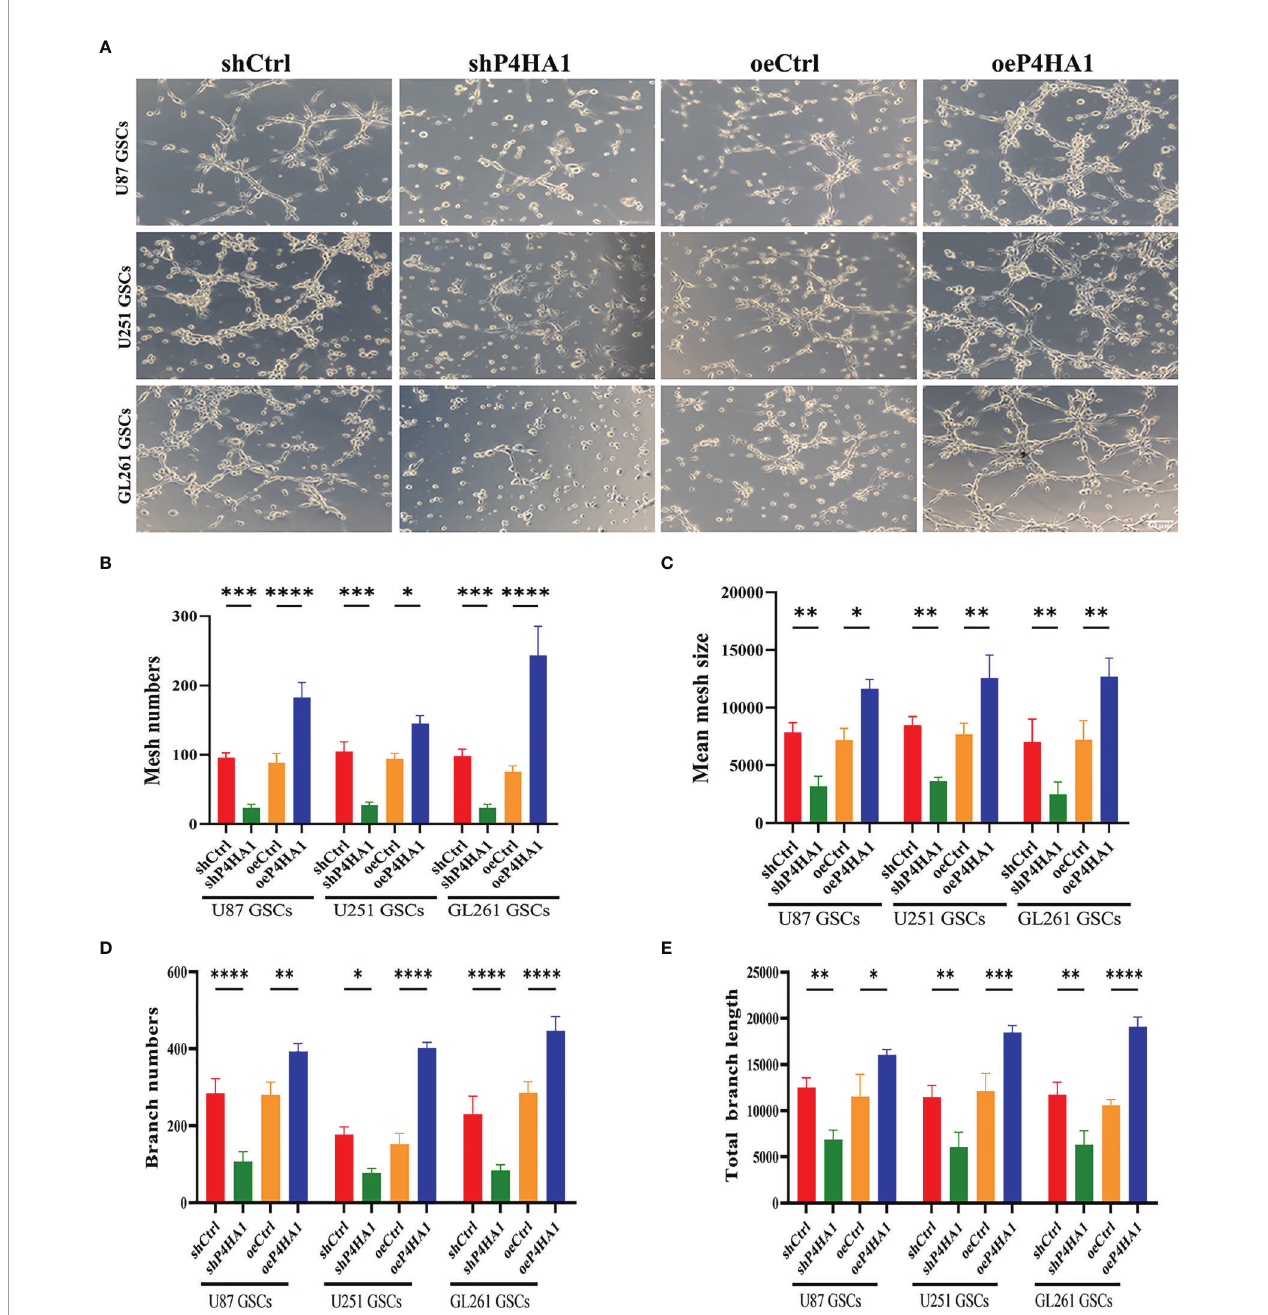
FIGURE 3 | Tube formation ability of GSCs with different P4HA1 expression levels. (A) GSCs derived from U87, U251 and GL261 were incubated in endothelial cell culture medium and 1% O 2 condition for 24 hours in a 24-well plate coated with 200ul matrigel matrix and then observed and photographed under a 200x light microscope(scale bar=50 m m). (B – E) Five visual fi elds were taken from each group, and the average mesh number (B) , mean mesh size (C) , the average branches number, and the average total branches length were calculated under ImageJ software. *P < 0.05, **P < 0.01, ***P < 0.001, ****P <